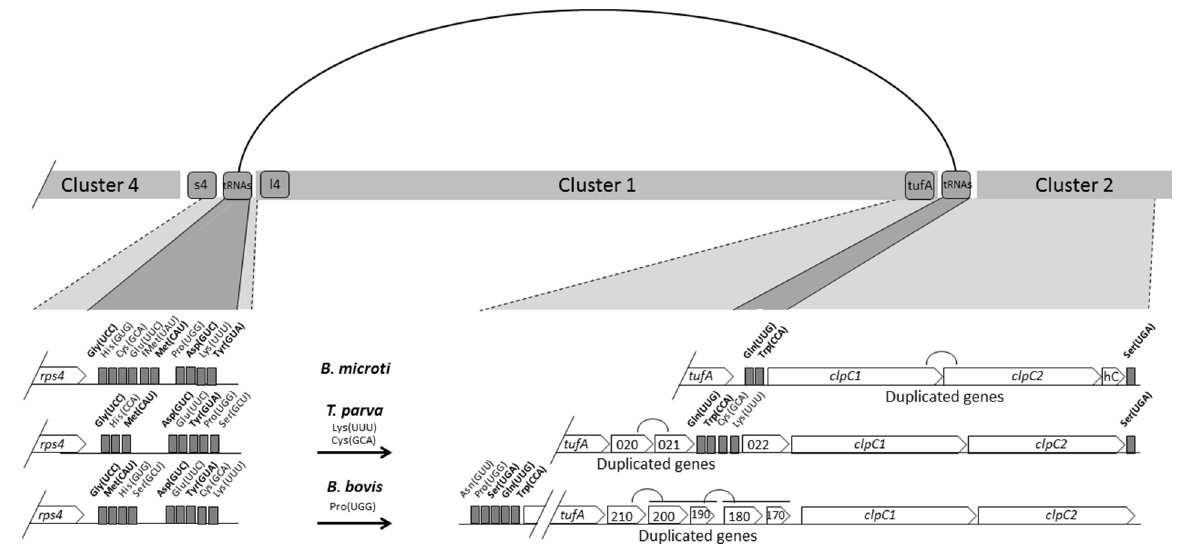
Figure 4. Schematic representation of the DNA regions surrounding cluster 1 in B.microti R1, B.bovis T2Bo and T.parva Mugaga. A line connecting the two ends of Cluster 1 indicate possible recombination events accounting for differences found in the gene organization and size between apicoplast genomes of piroplasmida.